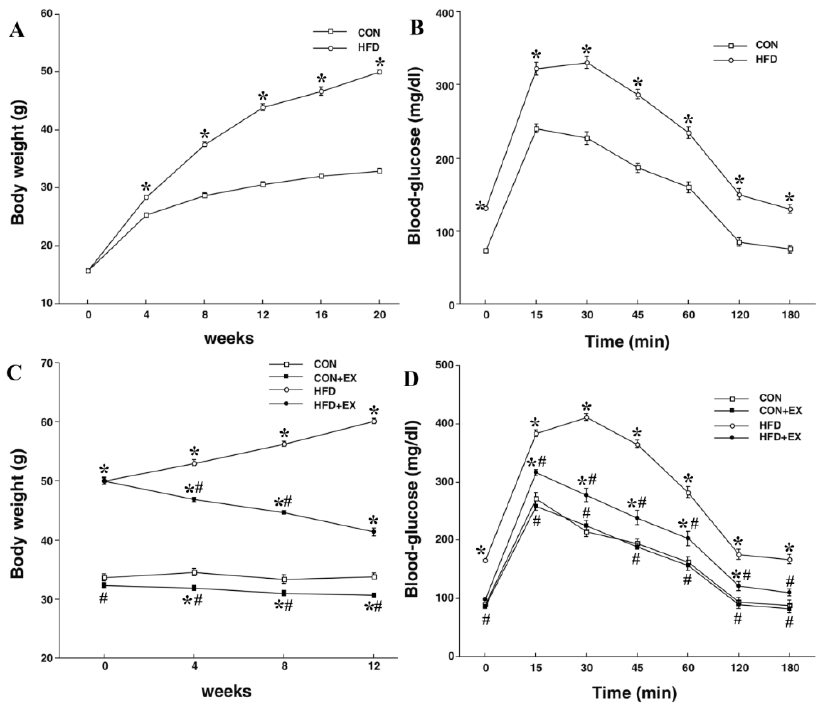
Figure 1. Effects of a high-fat diet (HFD) and treadmill exercise on body weight and blood glucose levels. Body weight ( A ) and blood glucose levels ( B ) after 20 weeks of a HFD. Body weight ( C ) and blood glucose levels ( D ) after 12 weeks of treadmill exercise. * Represents p < 0.05 as compared with the control (CON) group. # Represents p < 0.05 as compared with the high fat diet (HFD) group.